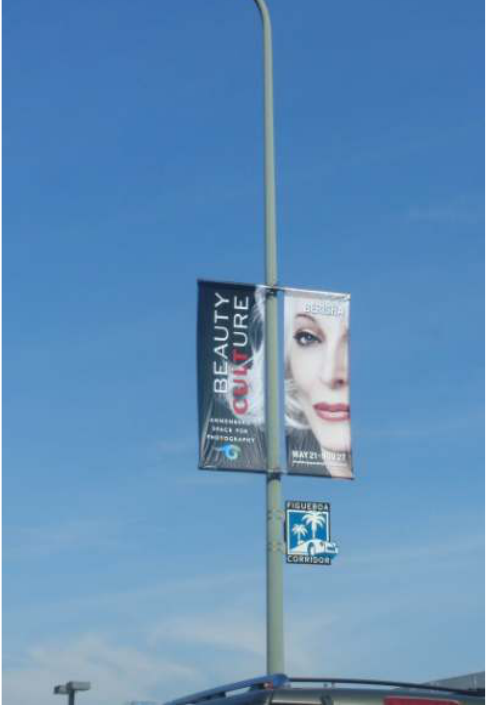
The ad is above a street sign for the Figueroa Corridor lined with palm-trees. Source: Charles